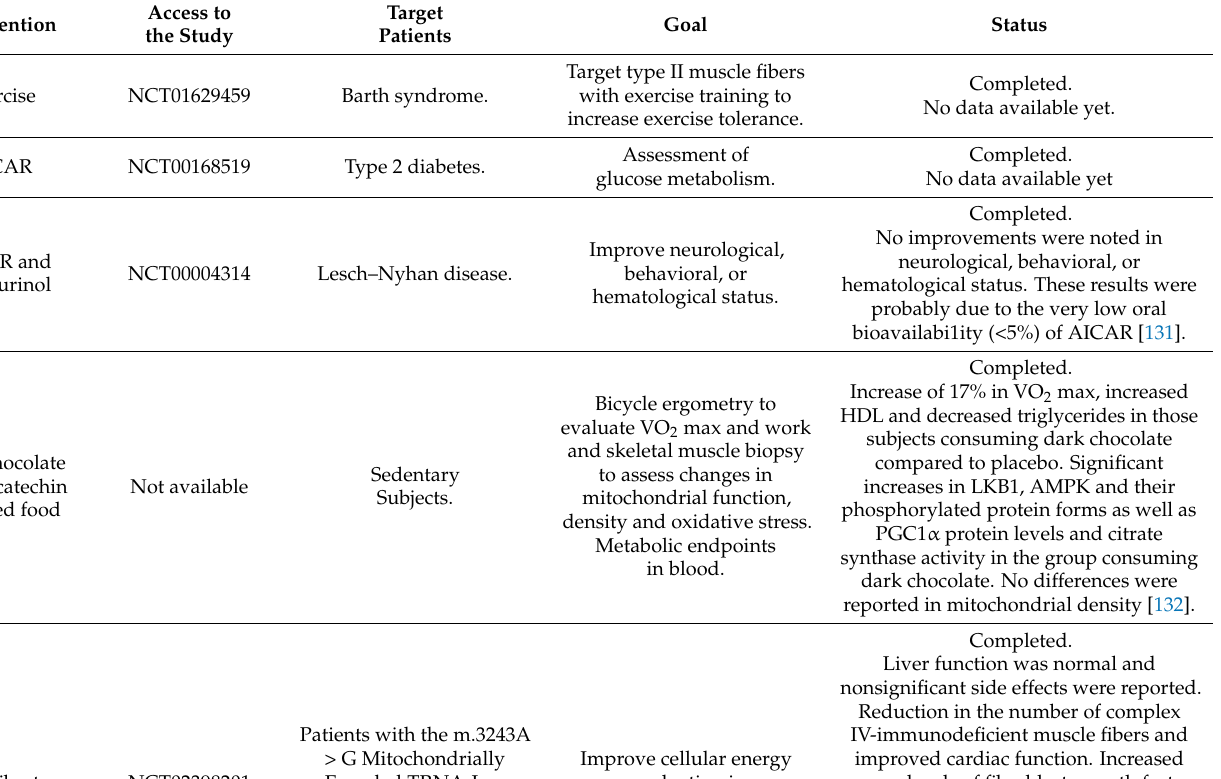
Table 1. Studies in humans aimed at promoting mitochondrial